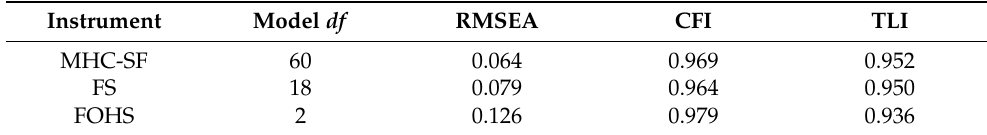
Table 3. GOF measures of the CFA for the three instruments.